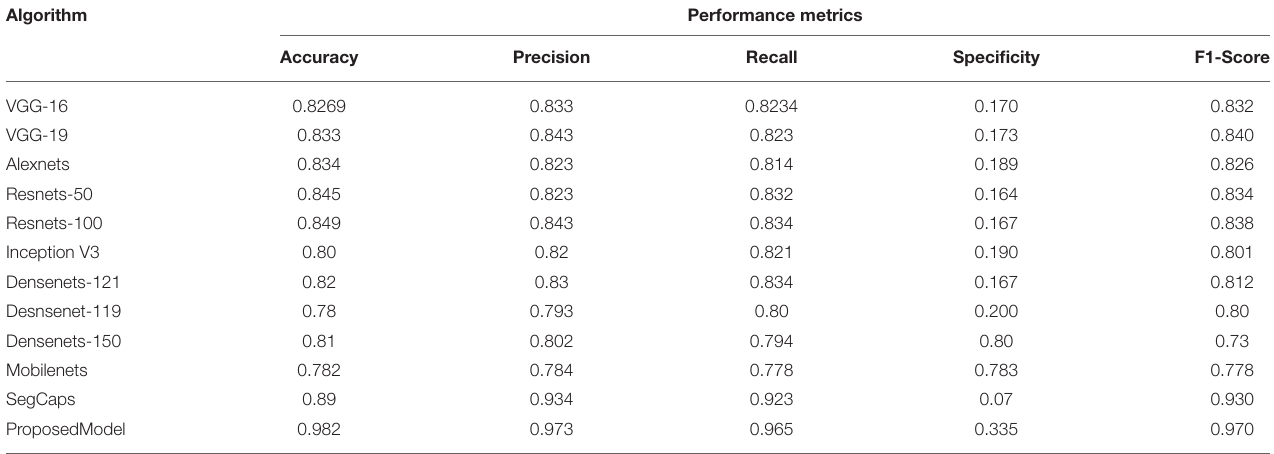
TABLE 4 | Comparative analysis of the different algorithms in detecting the COVID-19 using dataset 3.